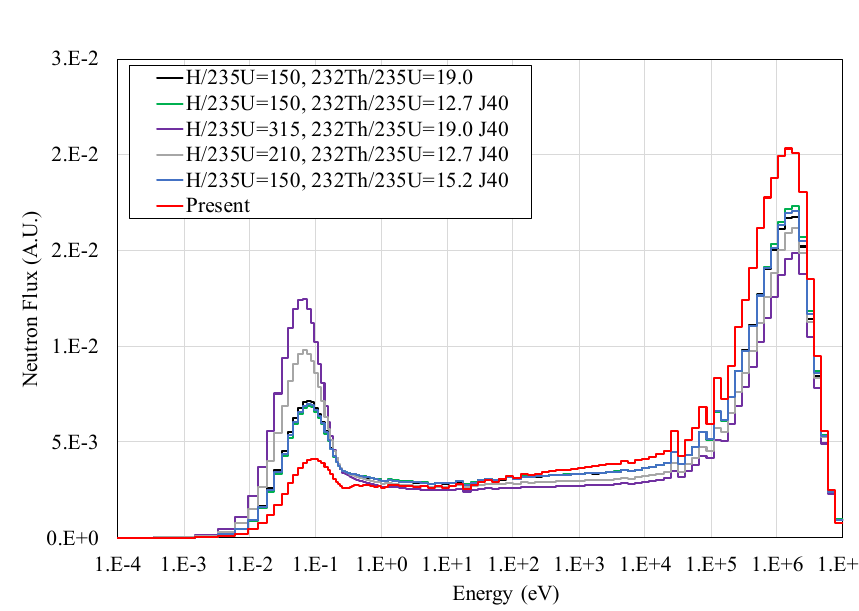
Figure 4. Neutron spectrum in each core.